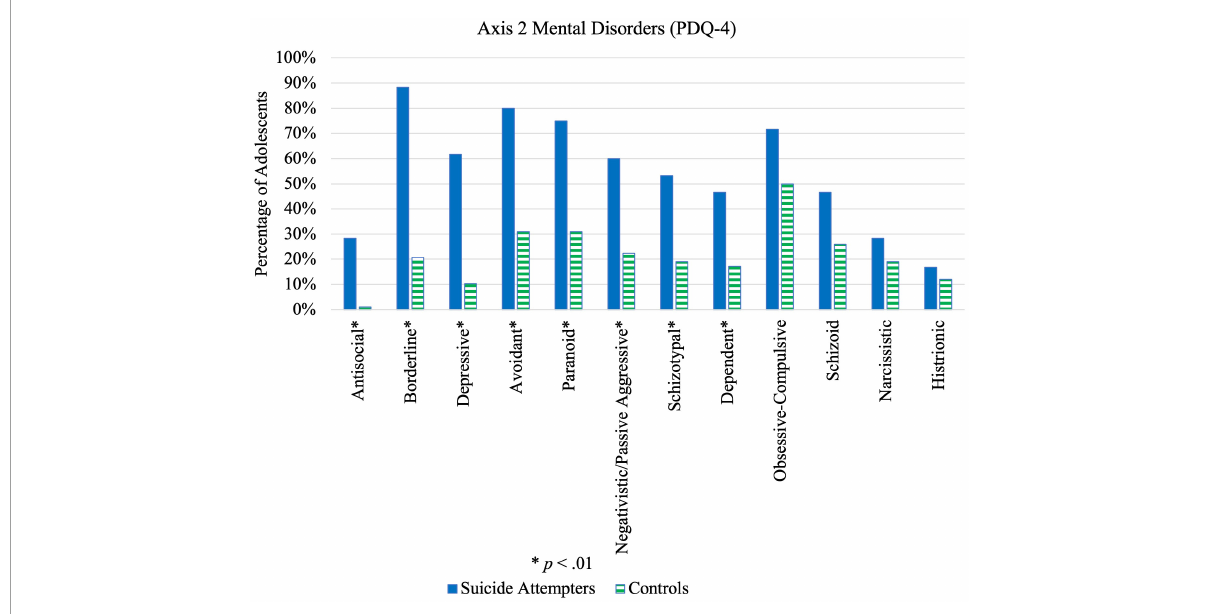
FIGURE5 Illustration of differences in Axis 2 mental disorders between suicide attempters and control group.